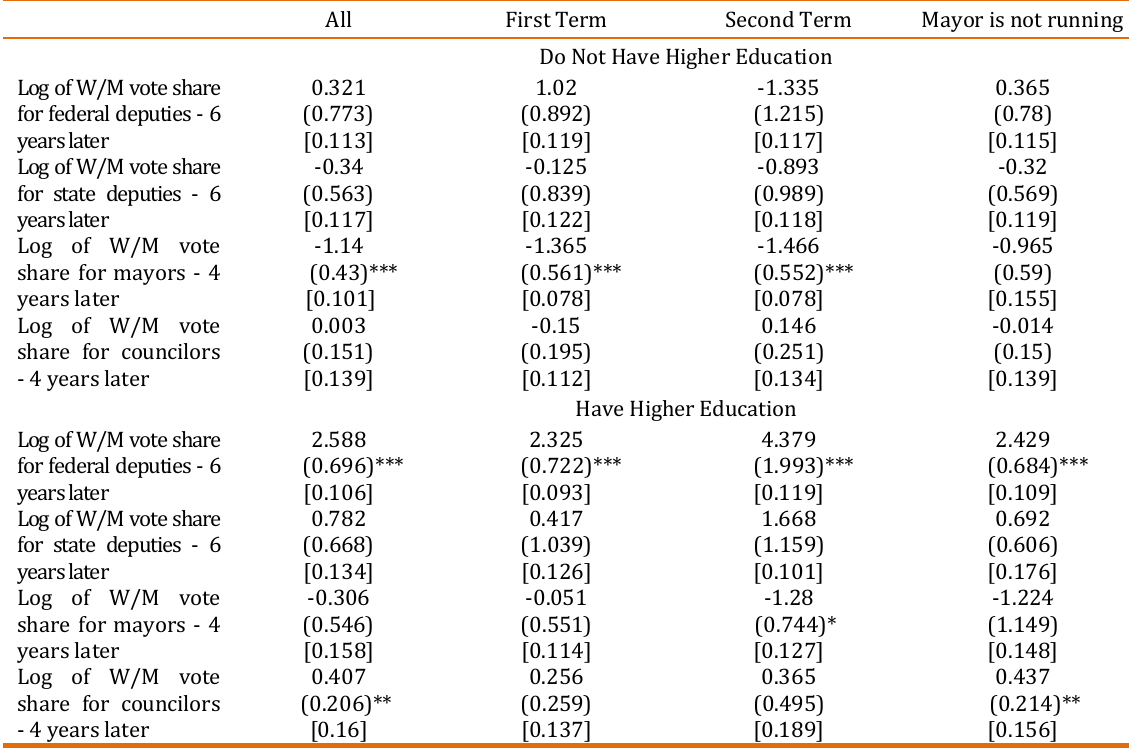
Table 06. Success of women in politics by educational level where women candidates are above the national